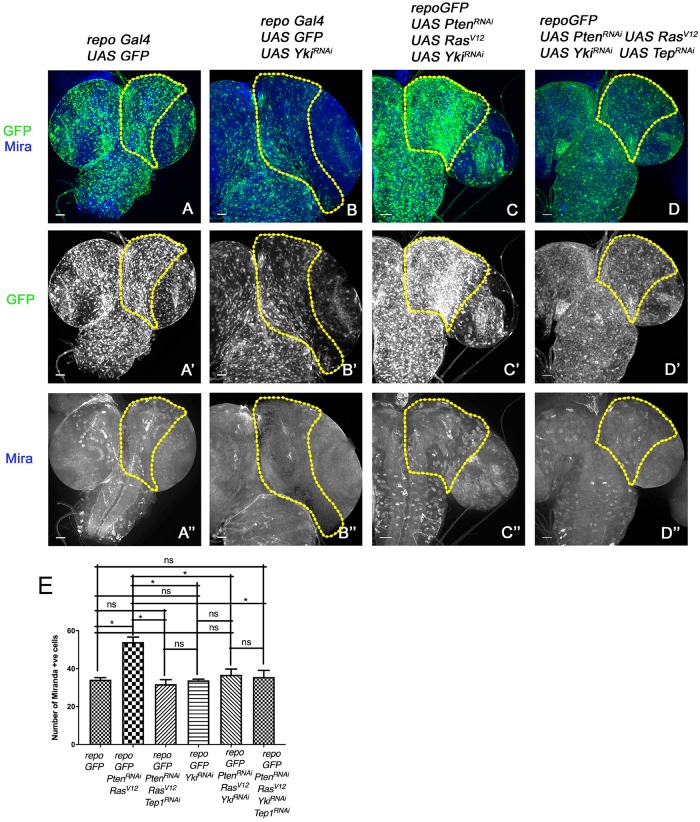
Downregulation of Yki reduces glioma growth and neuroblast number in larval CNS. (A–D”) panels show a comparison of neuroblast number in the central brain region (the yellow line marks the ROI in one brain lobe for each genotype). In all panels glia are marked by GFP (green, gray), and neuroblasts by Mira expression (blue, gray). The genotypes are: repo-GFP (A–A”), repo-GFP>UAS-YkiRNAi
(B–B”), repo-GFP>UAS-PtenRNAi; UAS-RasV12; UAS-YkiRNAi
(C–C”), and repo-GFP>UAS-PtenRNAi; UAS-RasV12; UAS-YkiRNAi/UAS-TepRNAi
(D–D”). (E) Quantification of number of Mira positive cells in the central brain region is shown for the indicated genotypes. Unpaired 2-tailed T-test with n = 5, 95% confidence was performed using GraphPad Prism 8, p < 0.05. Yellow ROI boxes indicate area in which Mira positive cells are counted. All images were scanned at identical magnification [20×, scale bars, 100 μm = 62px].